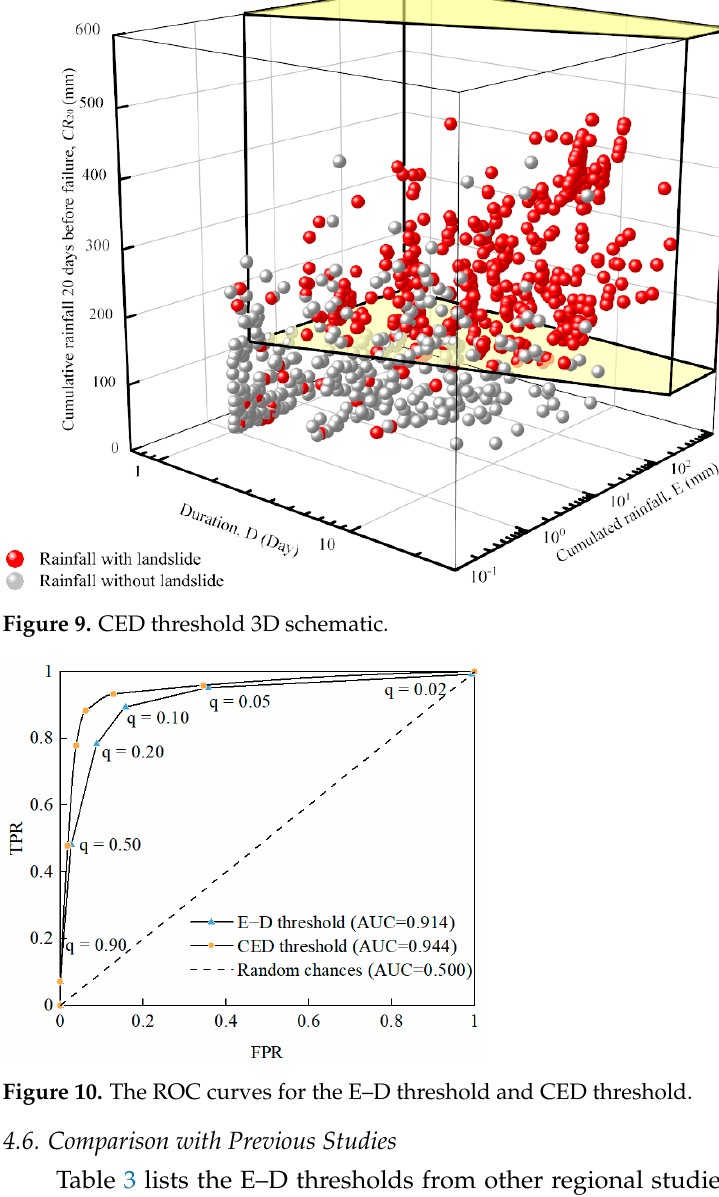
Figure 11. Comparison of the 5% probability level E–D thresholds defined in this work with previ ‐ ously published thresholds. The numbers refer to the numbers in Table 3.